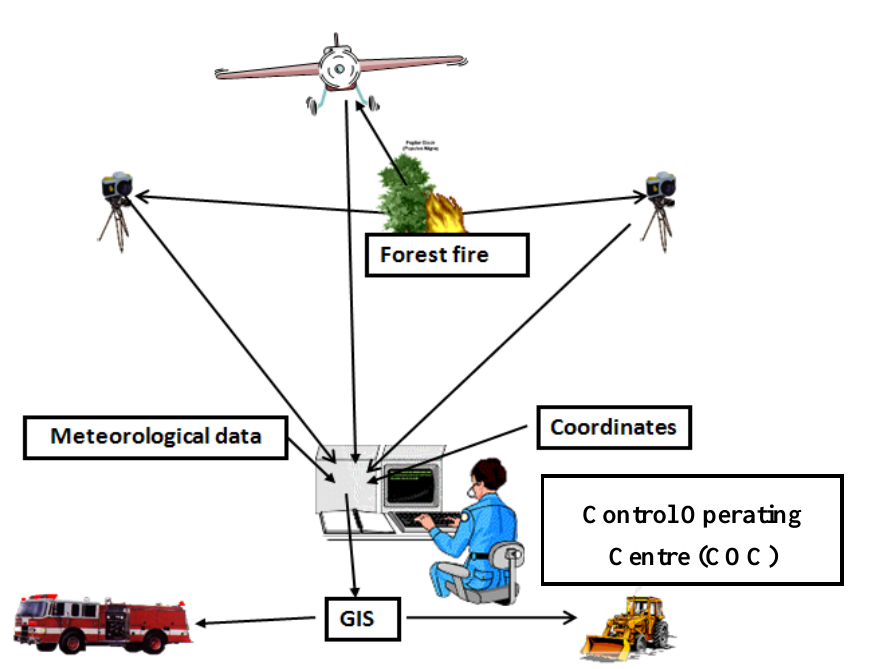
Figure 1. Description of the SITHON